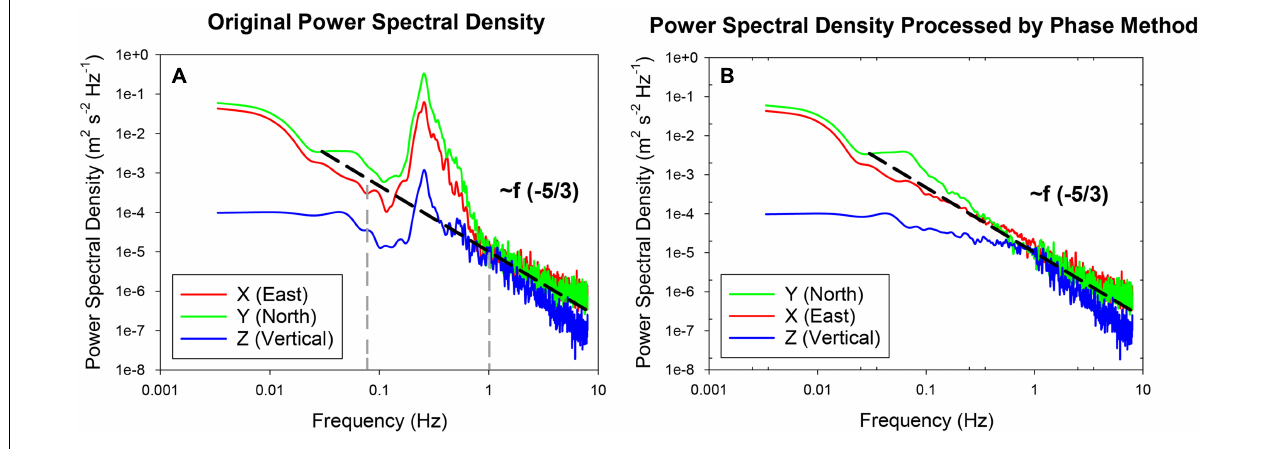
FIGURE 2 | Acoustic doppler velocimeter high frequency velocity data analysis: (A) original velocity power spectral density diagram (as an example); (B) the velocity power spectral density diagram processed by phase method after wave removal (X, Y, Z are the east, north, and upward velocity components measured by ADV, respectively, and the dotted line indicates that the turbulent energy dissipation process conformed to the -5/3 power of the Kolmogorov theory in inertial